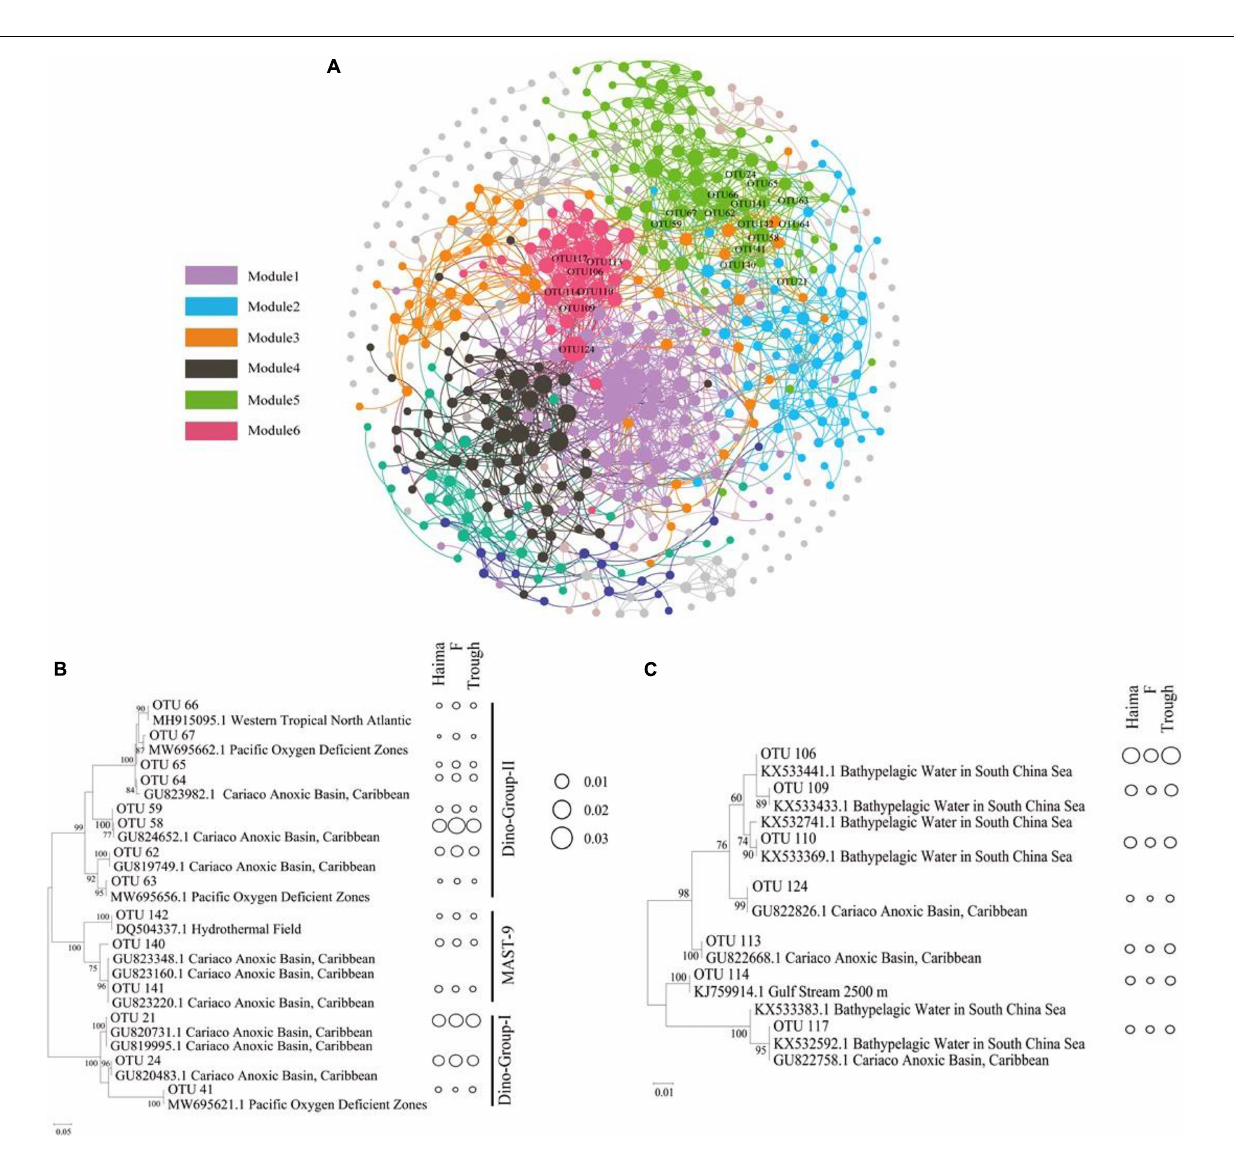
FIGURE 6 | Networks of co-occurring microbial eukaryotic taxa (OTU > 0.001) based on a correlation analysis within ecosystems (A) . The networks represent relationships between co-occurring ecosystems and the edges represent co-occurrence relationships consistent at the 0.6 correlation level. The nodes represent microbial eukaryotic taxa. Maximum-likelihood phylogenetic trees constructed with OTUs (relative abundance > 0.1) from module 5 for potentially parasitic Syndiniales and Stramenopiles (B) , and from module 6 for Spumellarida (C) . The size of bubbles reflects the proportion of each